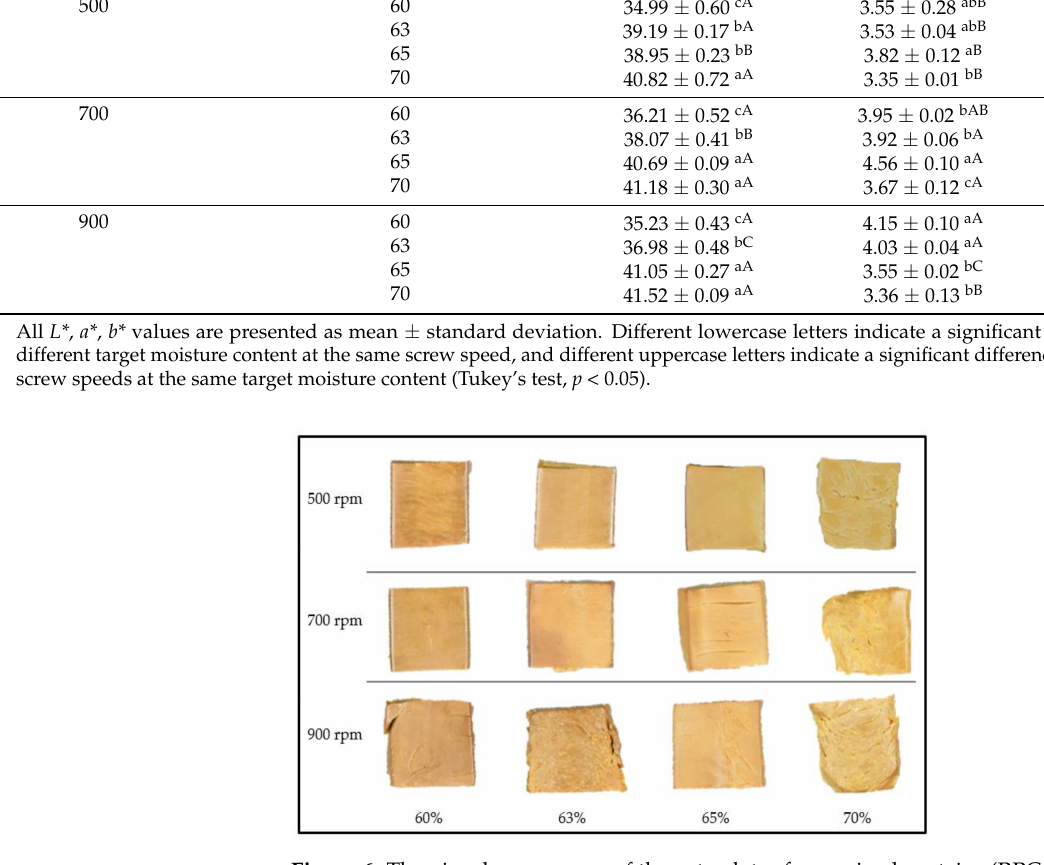
Figure 6. The visual appearance of the extrudates from mixed proteins (RPC: YPI) at different screw speeds and different target moisture